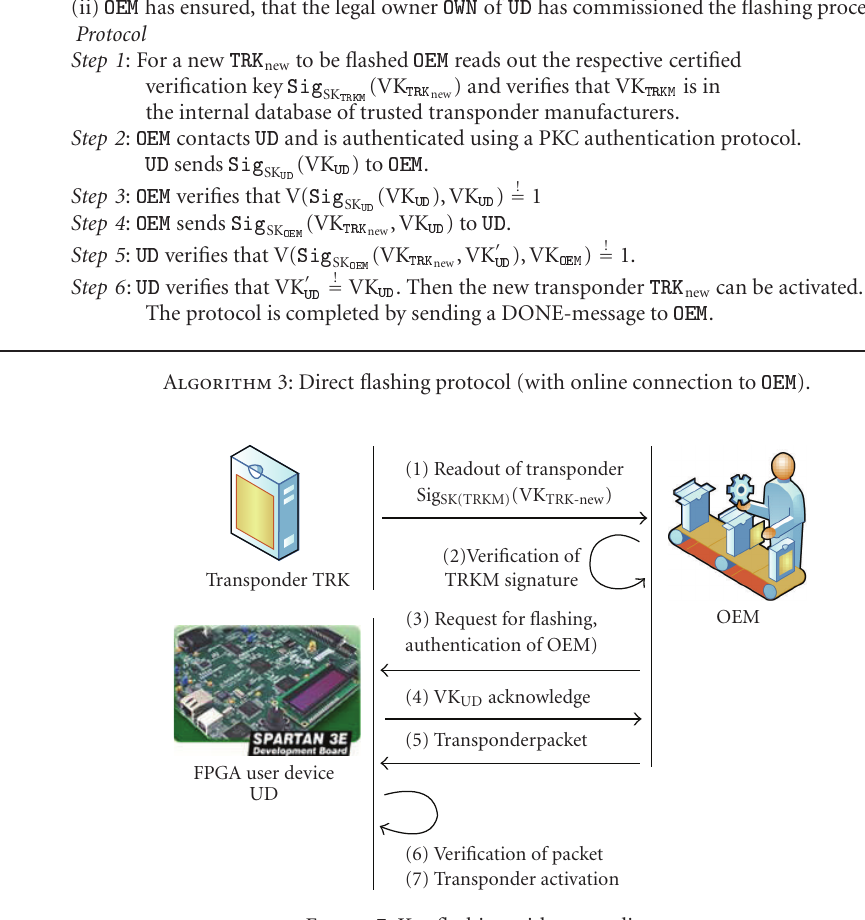
Figure 7: Key flashing without